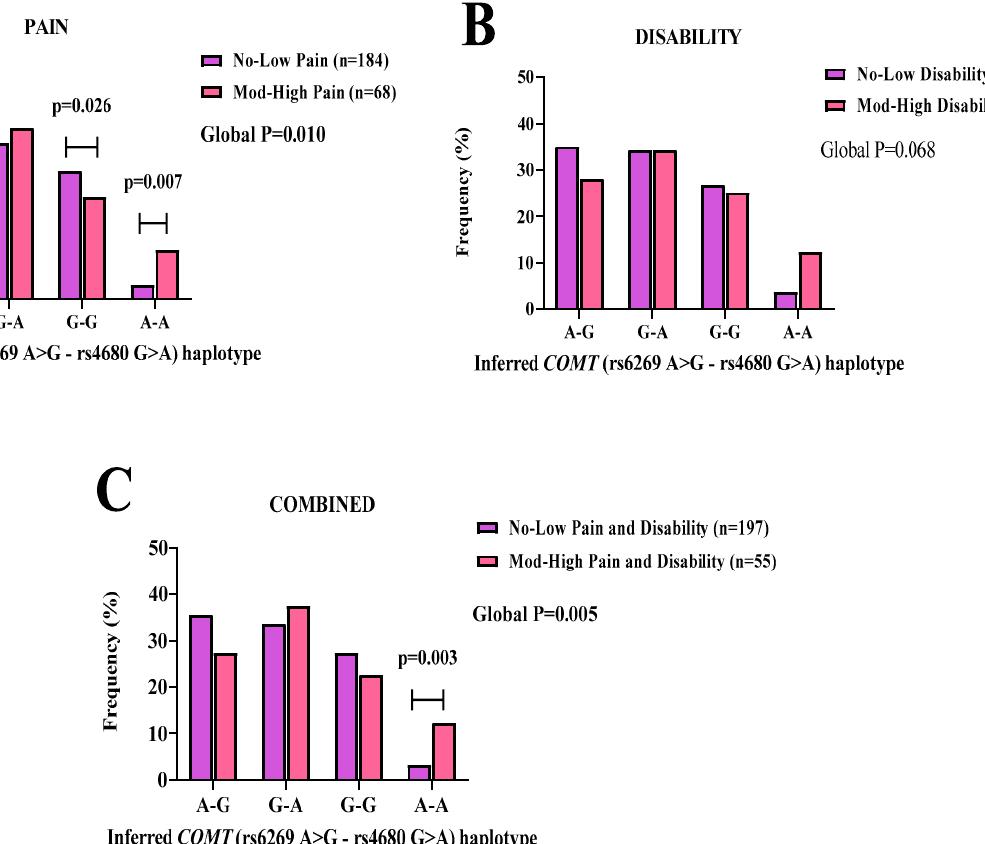
Figure 2. The inferred COMT (rs6269 A > G-rs4680 G > A) allele–allele combinations’ frequency distribution patterns are displayed for ( A ) pain, ( B ) disability, and ( C ) combined (pain and disability) symptoms in SA BCS. No-low (purple bars) and moderate-high (pink bars) groups are displayed with the number of participants in parenthesis (n). Statistically significant ( p < 0.05) frequency differences are noted with an age-adjusted p -value in bold.